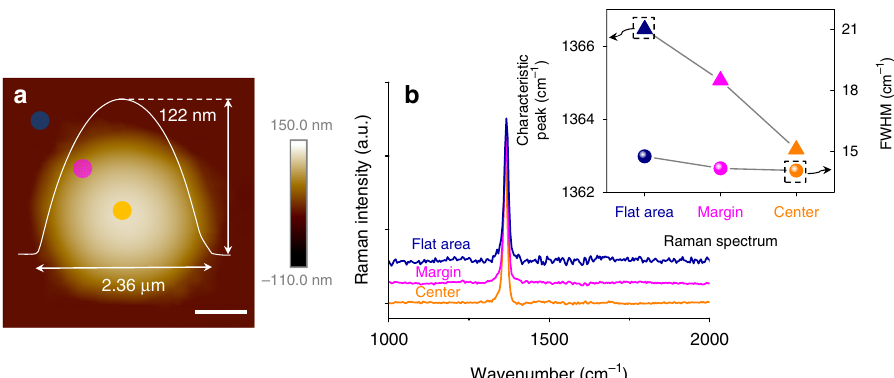
Fig. 6 Raman spectra taken at different positions of an h -BN bubble. a AFM image of a typical h -BN bubble; the white curve shows the pro fi le across the center of bubble and gives information about its height and diameter. Scale bar, 600 nm. b Raman spectra taken at the positions indicated in the AFM image. The inset shows the variation in the E 2g peak position and FWHM between positions. A redshift in the E 2g peak position from the fl at area to the center of the bubble is observed, while the corresponding FWHM is